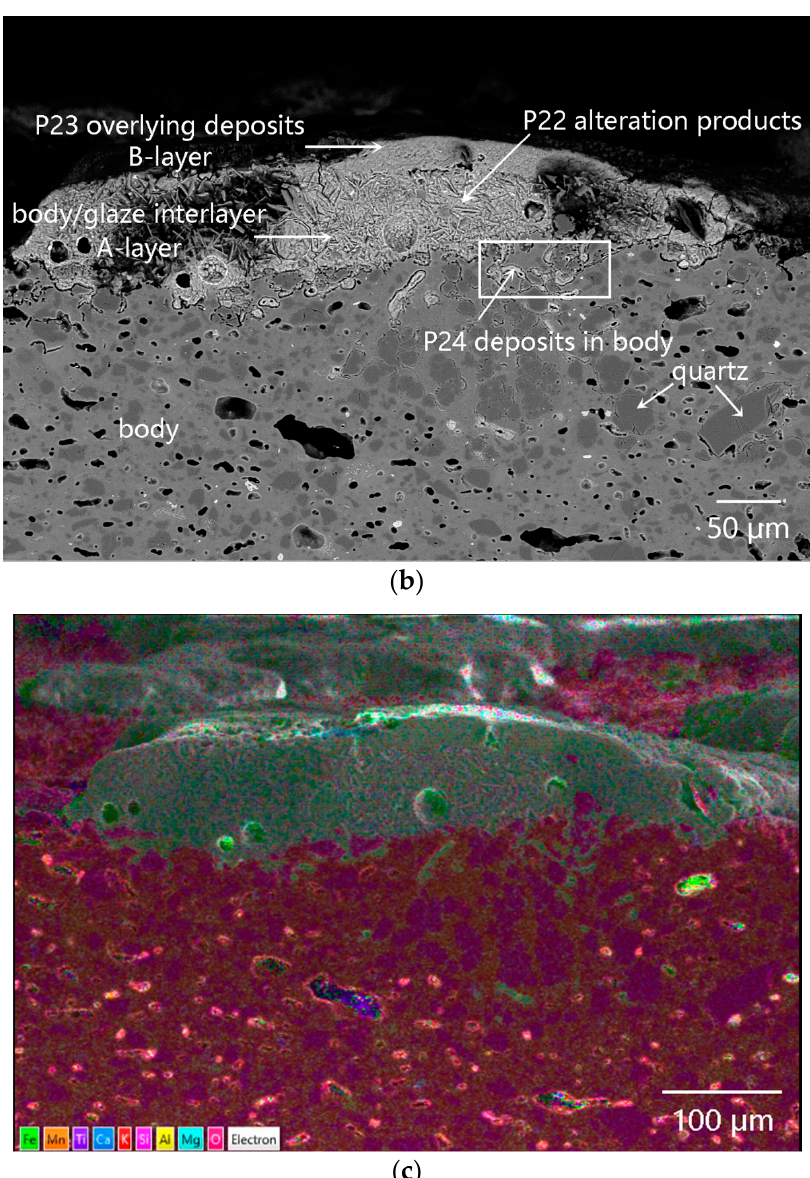
Figure 14. Cross-sectional morphology and element mapping image at the position of residual glaze of sample DL-1: ( a ) OM image, ( b ) SEM image, and ( c ) element mapping images.